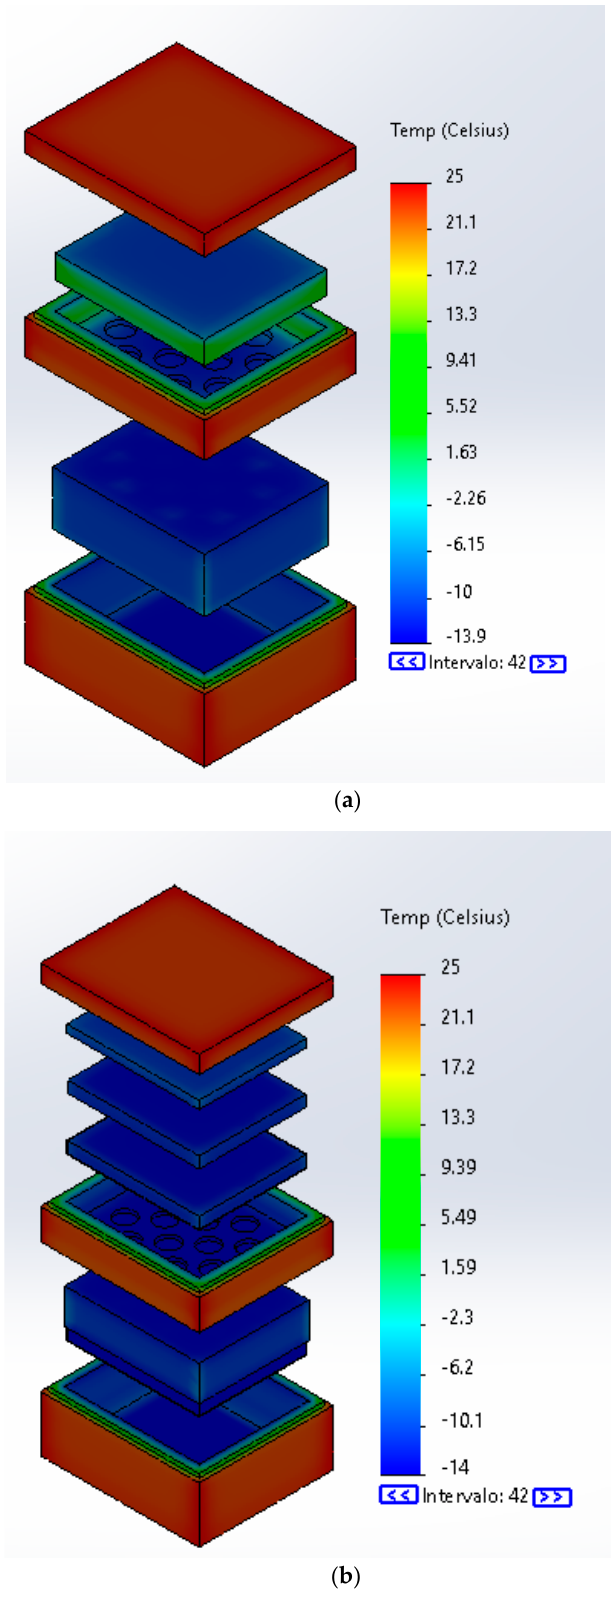
Figure 6. Temperature simulation result. ( a ) Simulation of the isothermal box without PCM ( b ) simulation of the isothermal box with the PCM. Table 6. Temperature simulation comparison.